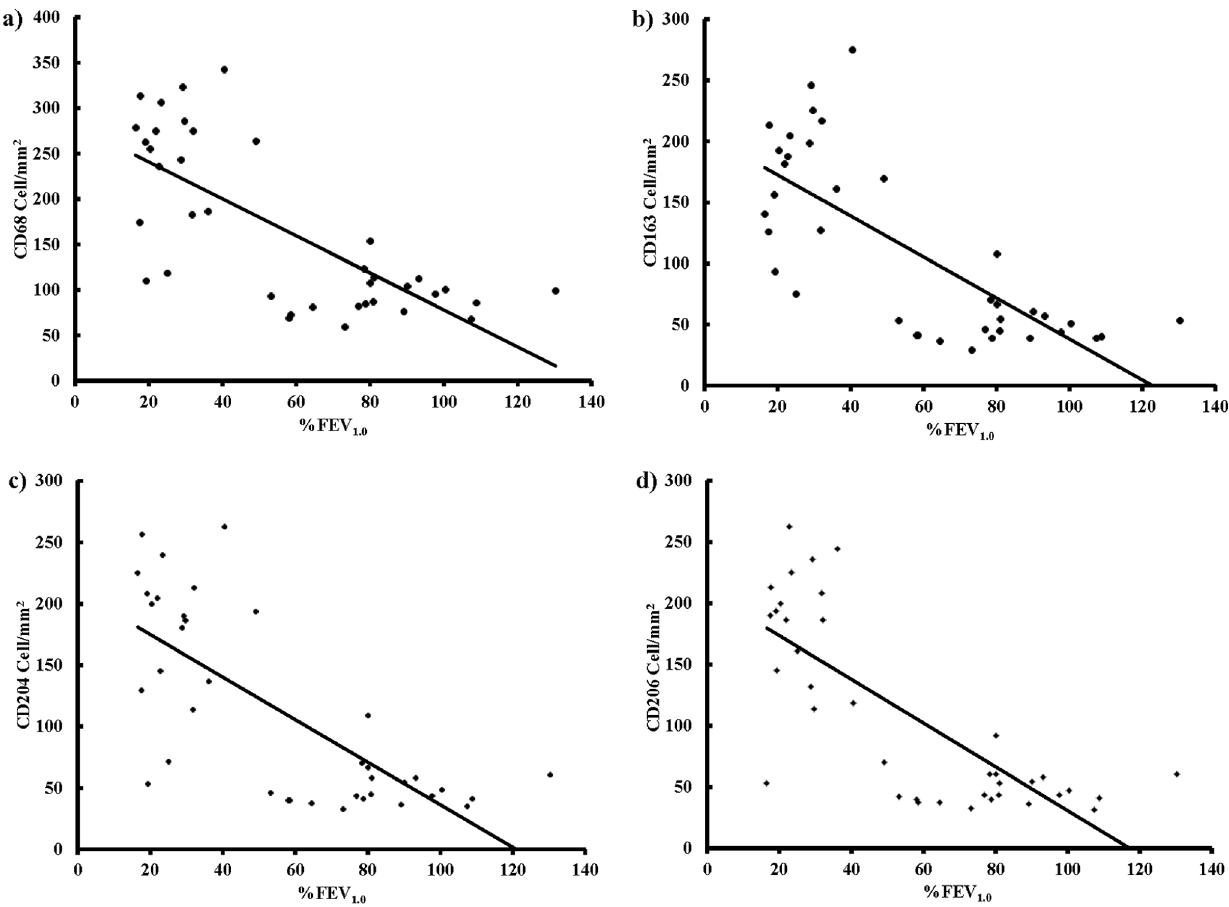
Figure 6. Correlation between the number of CD68, CD163, CD204 or CD206 positive cells and lung function measured as forced expiratory volume in one second % predicted (%FEV 1.0 ) in chronic obstructive pulmonary disease patients (n=38). a) The number of CD68 positive cells and %FEV 1.0 (r=0.729 and p , 0.01), b) The number of CD163 positive cells and %FEV 1.0 (r=0.739 and p , 0.01), c) The number of CD204 positive cells and %FEV 1.0 (r=0.732 and p , 0.01), d) The number of CD206 positive cells and %FEV 1.0 (r=0.765 and p ,